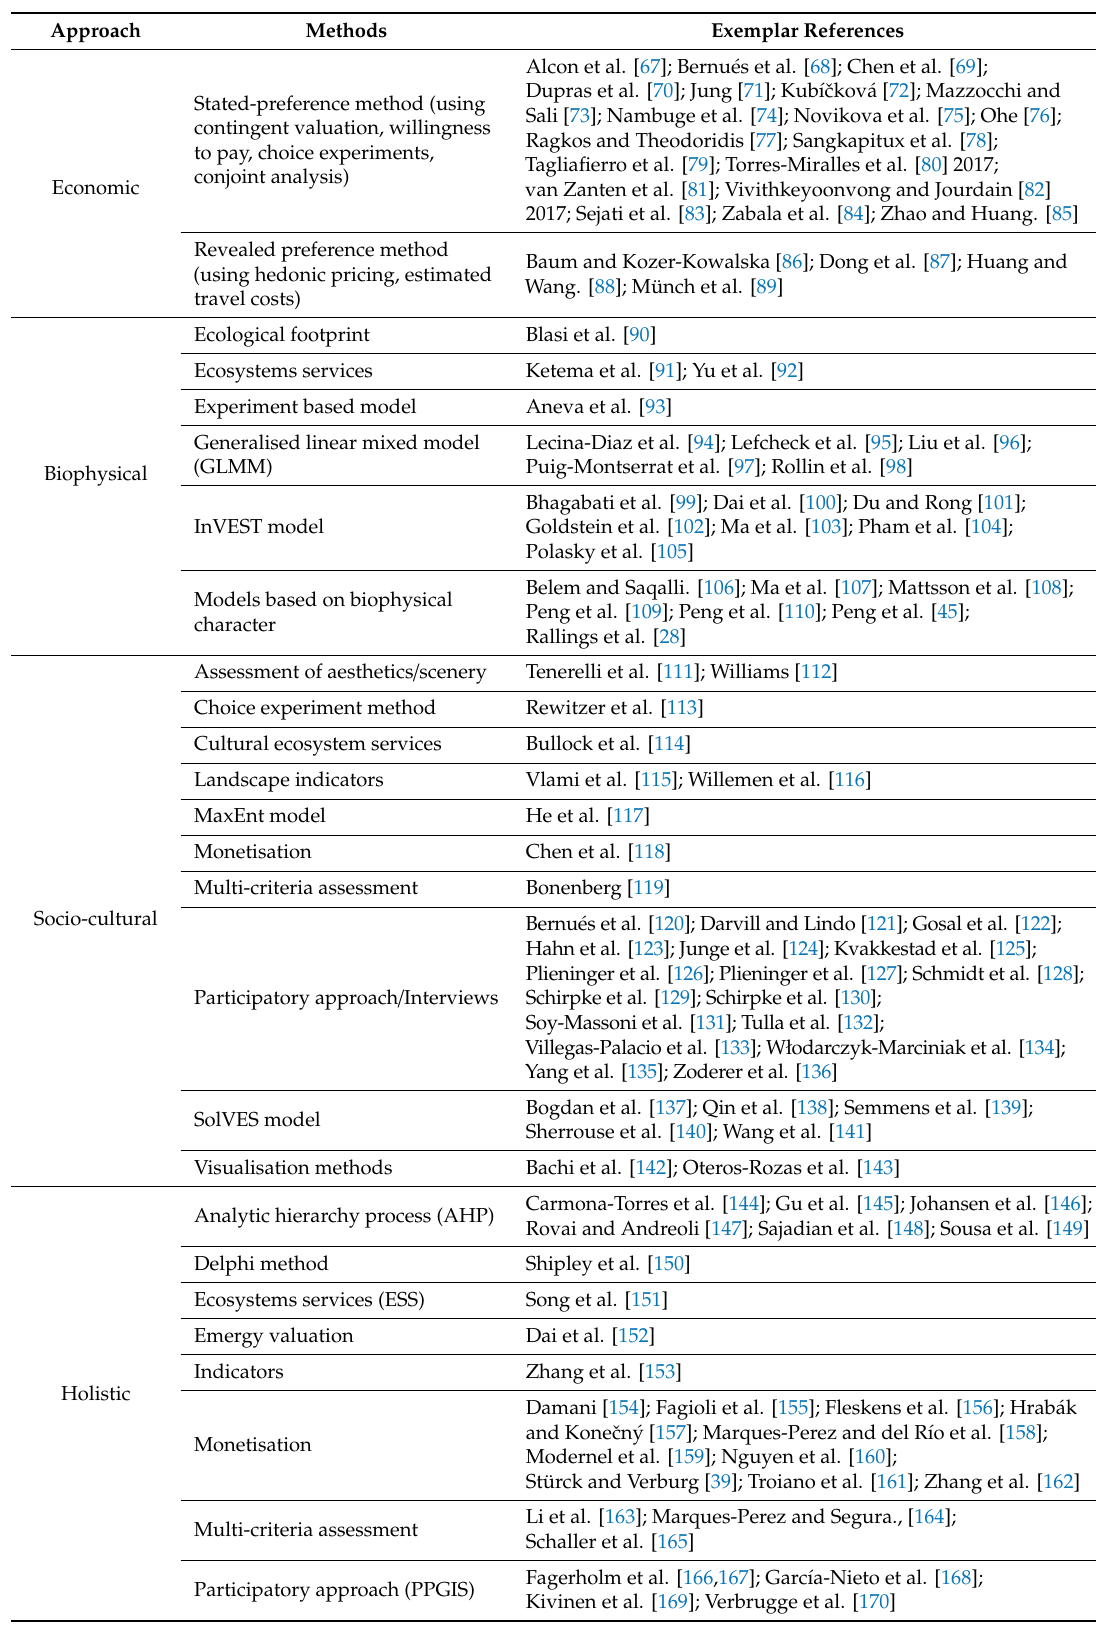
Table 2. Summary of approaches and methods used in assessing and measuring